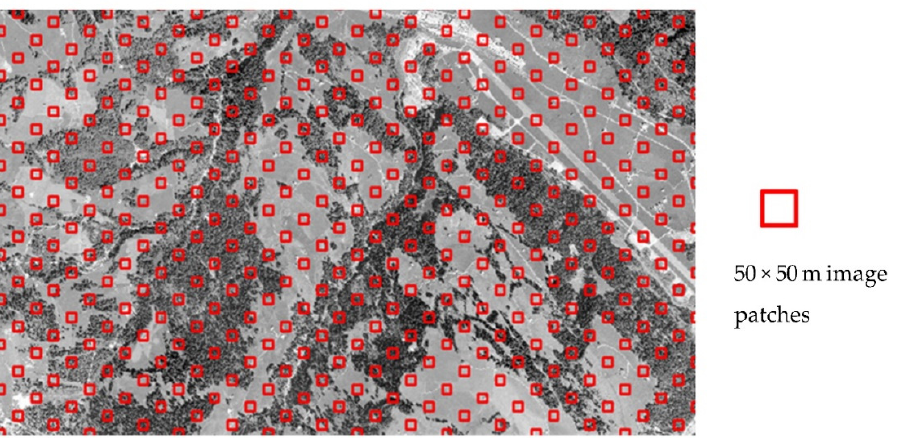
Figure 8. Example of the visual image interpretation in study area 1. The three classes “dense forest”, “group of trees”, and “other” were interpreted on the 50 × 50 m image patches (red boxes).